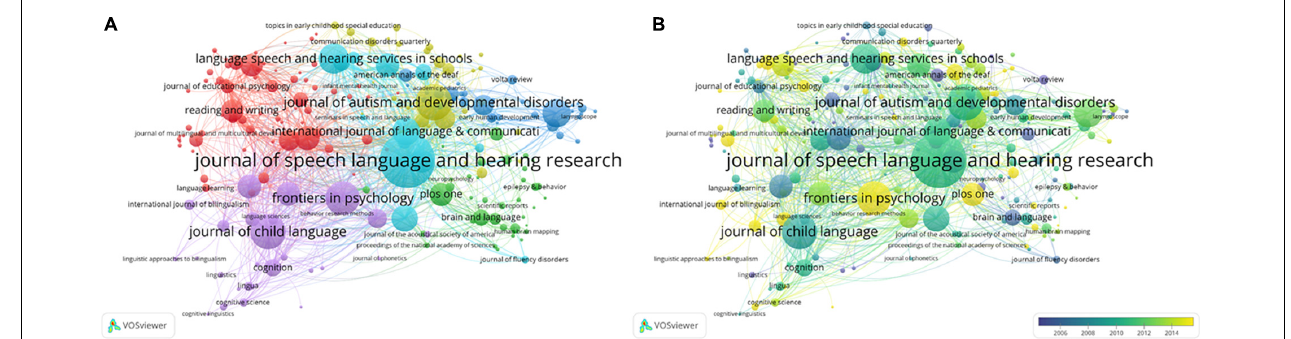
FIGURE 4 | The visualization map of prominent journals. (A) Network visualization; (B) an overlay visualization map.